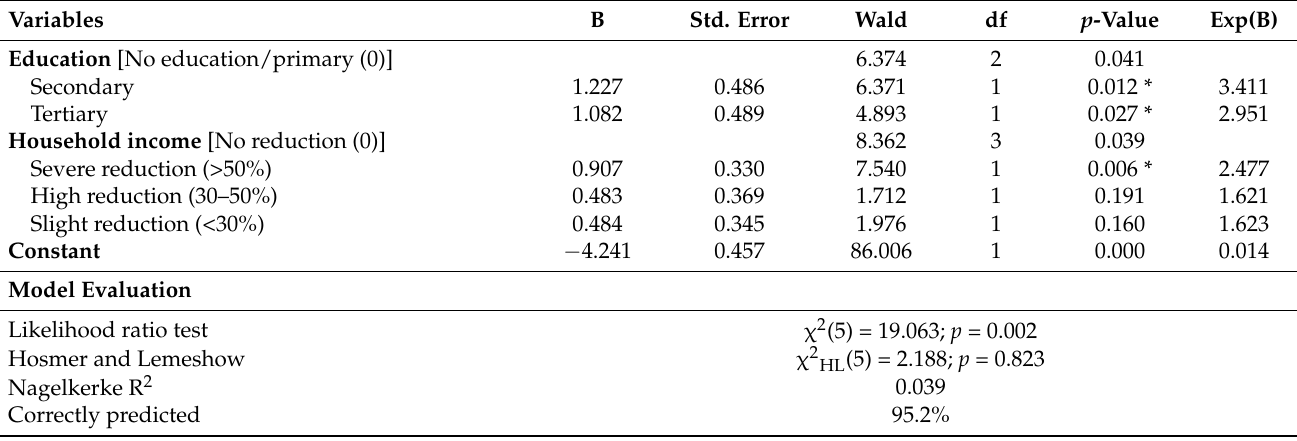
Table 3. Model 2—Socioeconomic determinants of victimization during the pandemic.